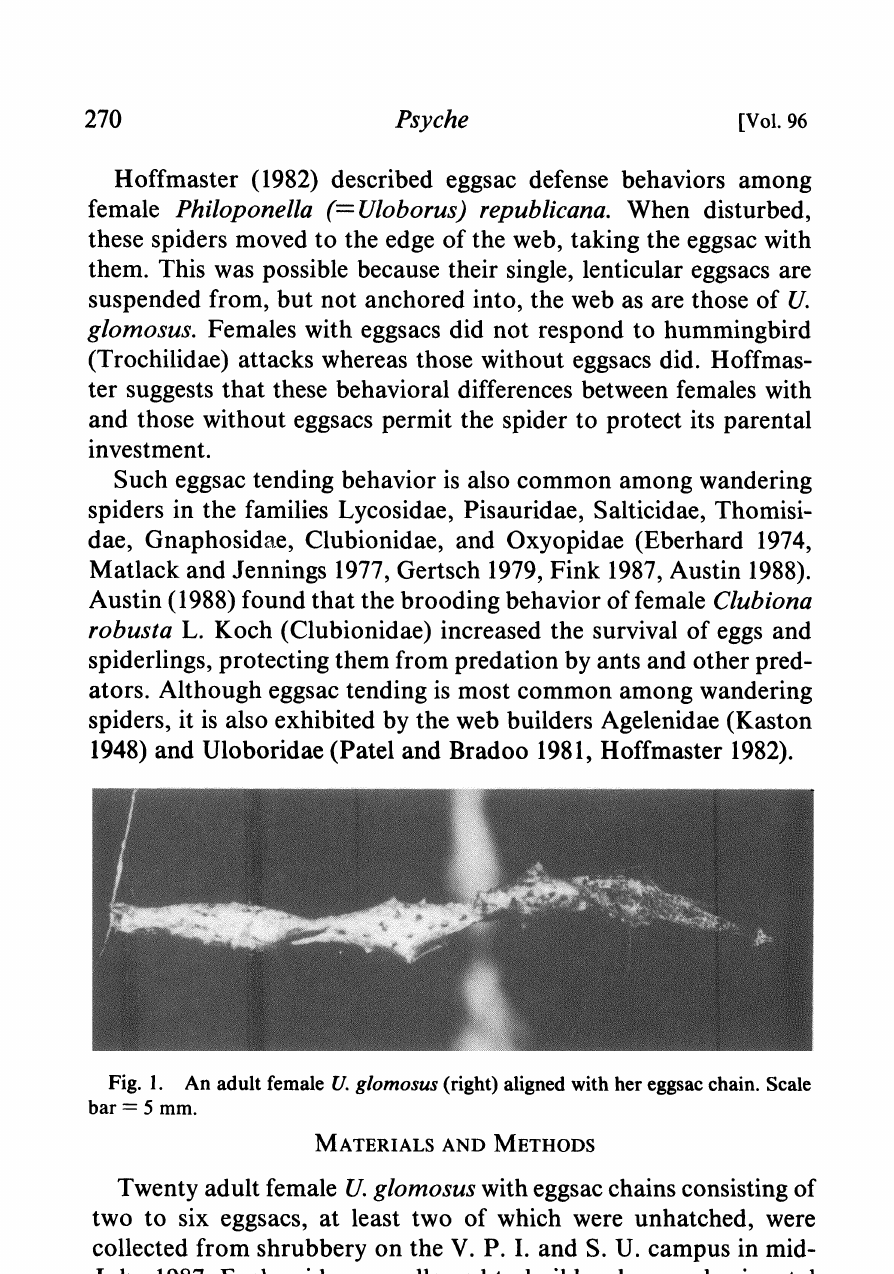
Fig. 1. An adult female U. glomosus (right) aligned with her eggsac chain. Scale bar--- 5